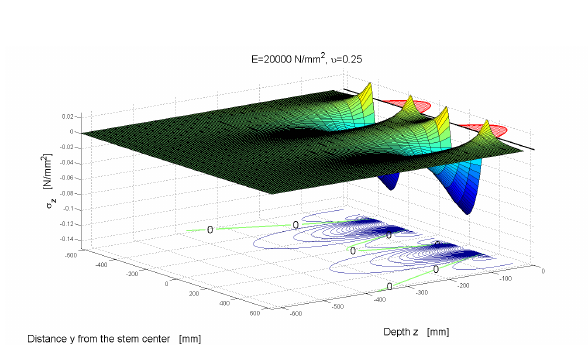
Figure 33: 3-D surface and stress contours of on the A-A vertical cross-section of Figure 32 (second order solution).